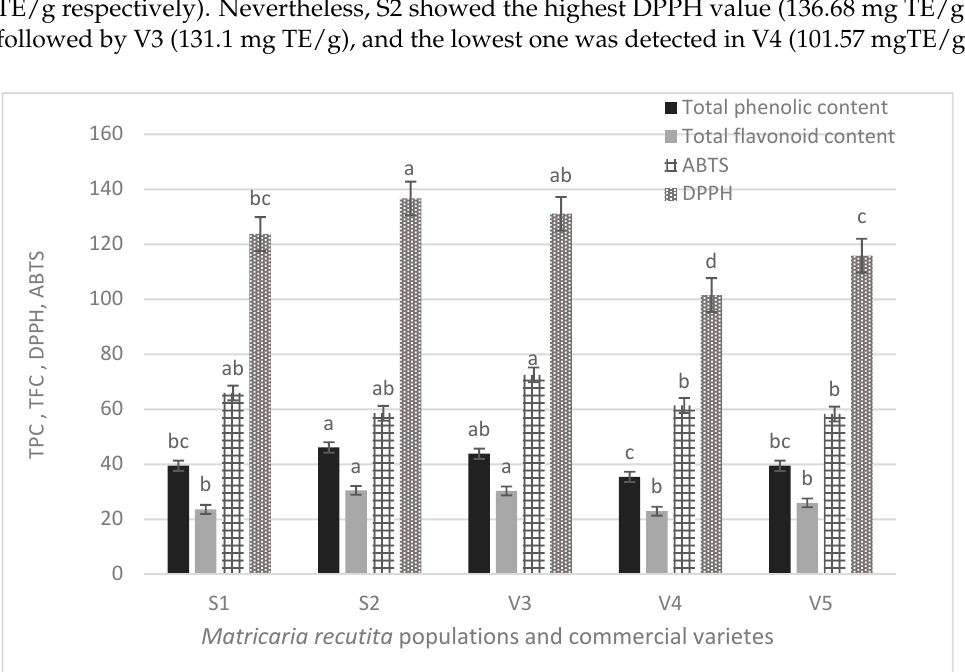
Figure 4. Total phenolic content (TPC, mg GAE/g extract), total flavonoid content (TFC, mg CATE/g extract) and antioxidant capacity (estimated by DPPH and ABTS assays, mg TE/g extract) of Matricaria recutita flowers; bars with the same color followed by the different letter were significantly different ( α = 0.05).